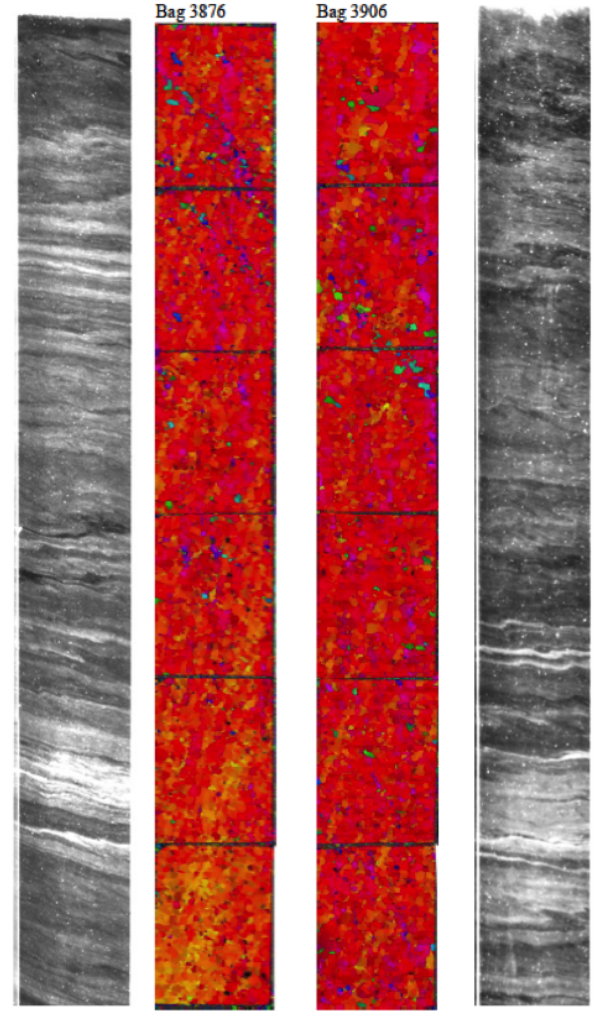
Figure 7. Comparison of entire 55cm core sections (full bags) of line scan (a, d) and fabric data (b, c)